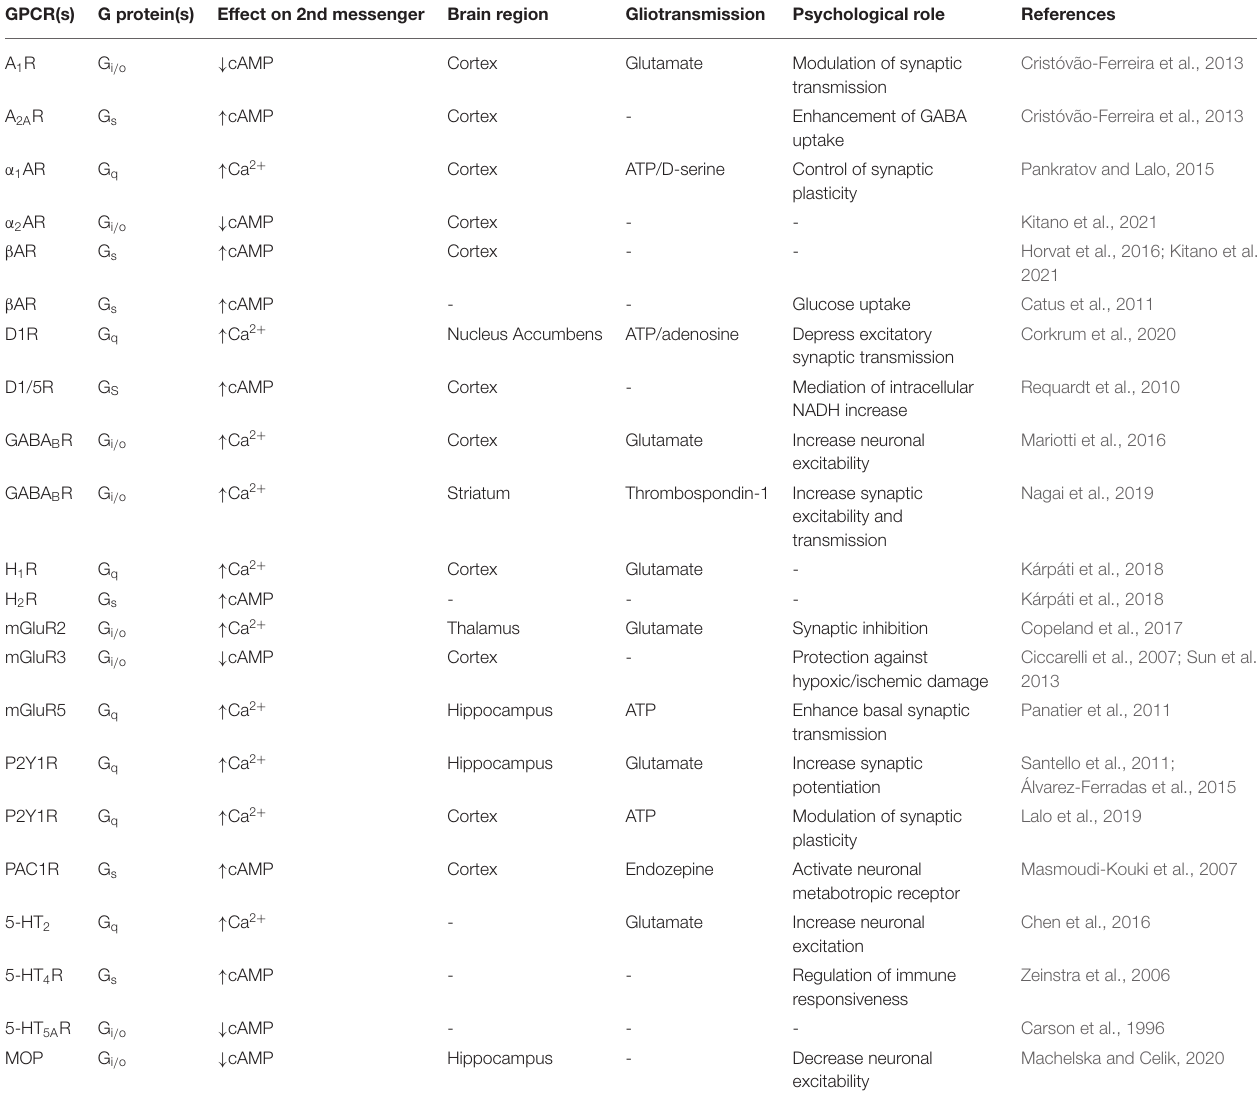
TABLE 1 | Astrocytic Ca 2 + /cAMP modulation by GPCR receptors and their physiological role in diverse brain areas. GPCR(s) G protein(s) Effect on 2nd messenger Brain